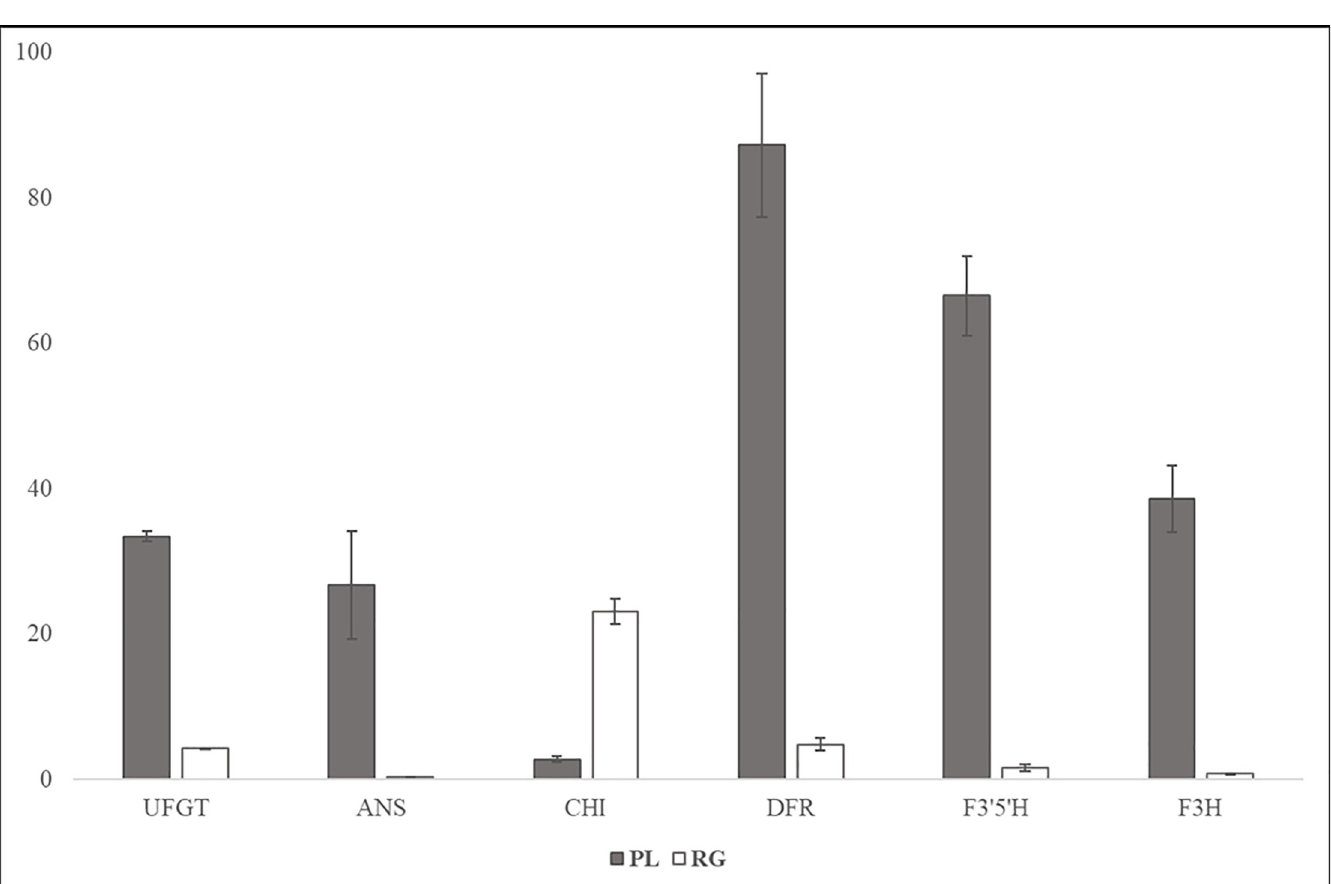
Fig 9. qPCR analysis of anthocyanin biosynthesis-related genes in green- and purple-leaf SYQ cultivars.